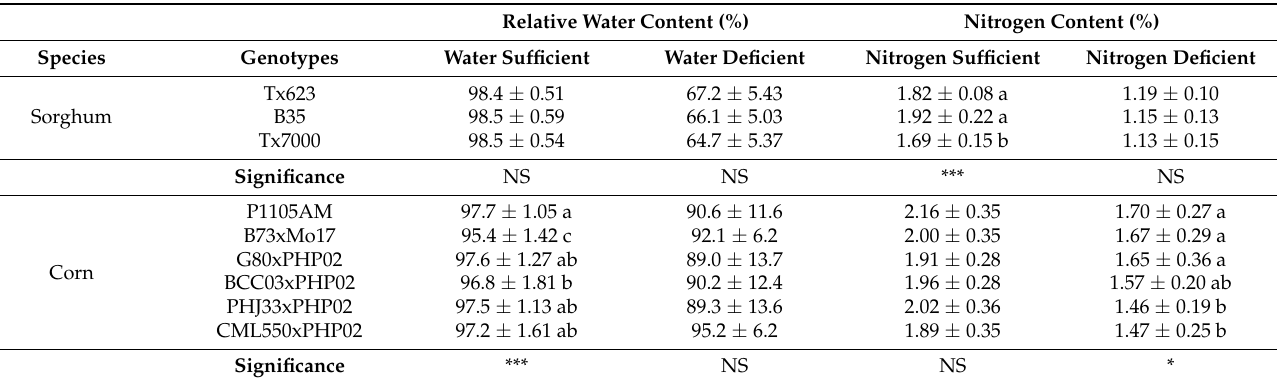
Table 3. Effects of genotypes on relative water content and nitrogen content under different water and nitrogen